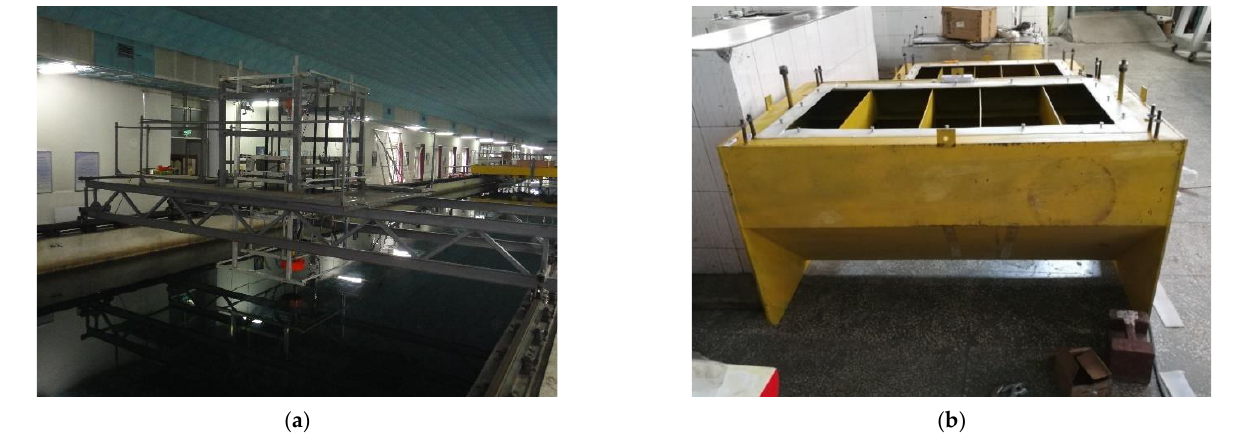
Figure 2. Experimental model setup. ( a ) mechanical device for free-falling test; ( b ) wedge structure steel model.